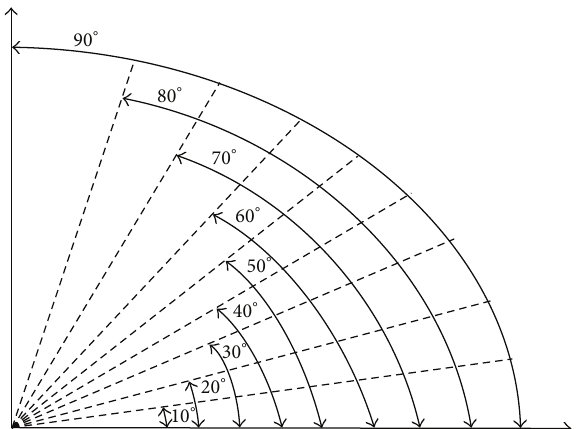
Figure 8: Curing angles of laminated